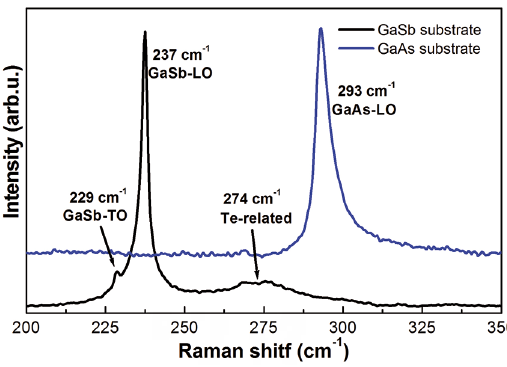
Figure 5: Raman spectra of the substrates used in the growth of thin films of ZnTe.